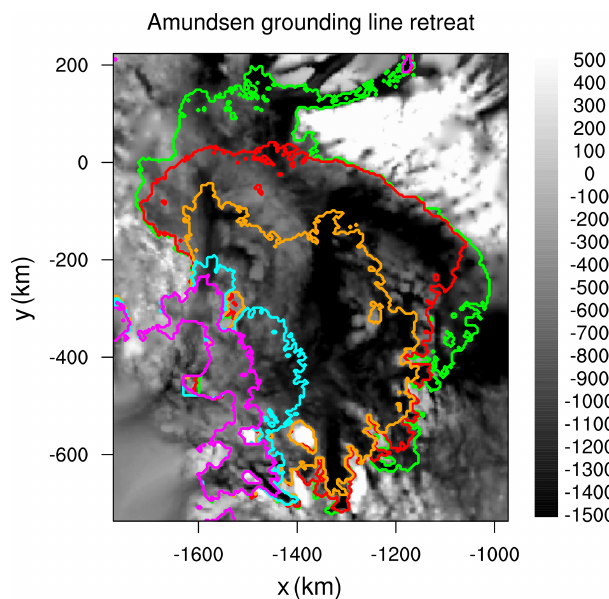
Figure 23. Grounding-line retreat in the Amundsen sector during a 550-year projection experiment using the nonlocal-PIGL melt scheme, corresponding to the black line in the lower left panel of Fig. 21. Seafloor topography (m) is shaded on a gray scale. The solid lines show boundaries of floating ice in the years 2100 (mauve), 2200 (cyan), 2300 (orange), 2400 (red), and 2500 (green).